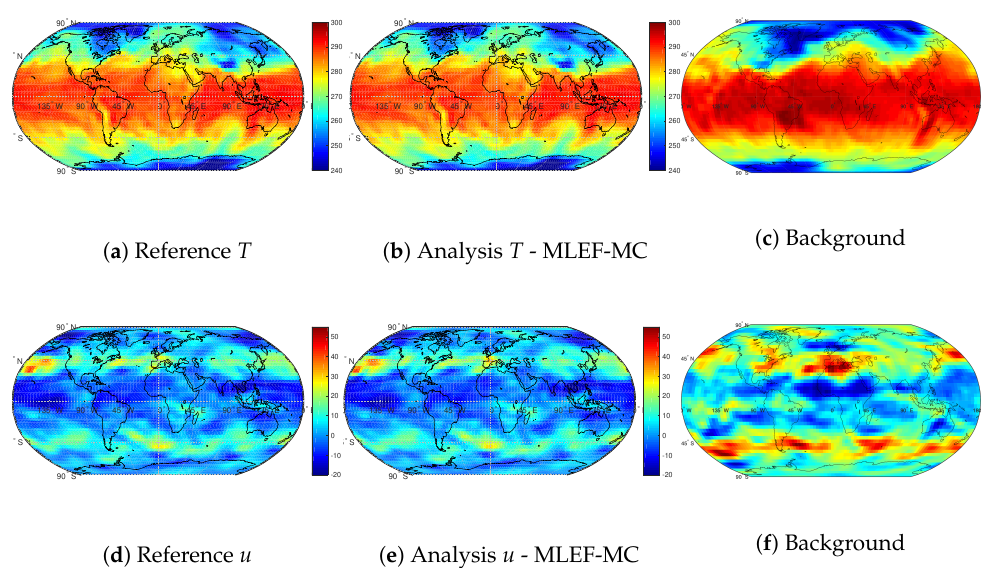
Figure 13. Snapshots of the SPEEDY model for the reference solution, the background estimate, and the analysis of the MLEF-MC. Results are shown for the first numerical layer (100 hPa), and the first assimilation